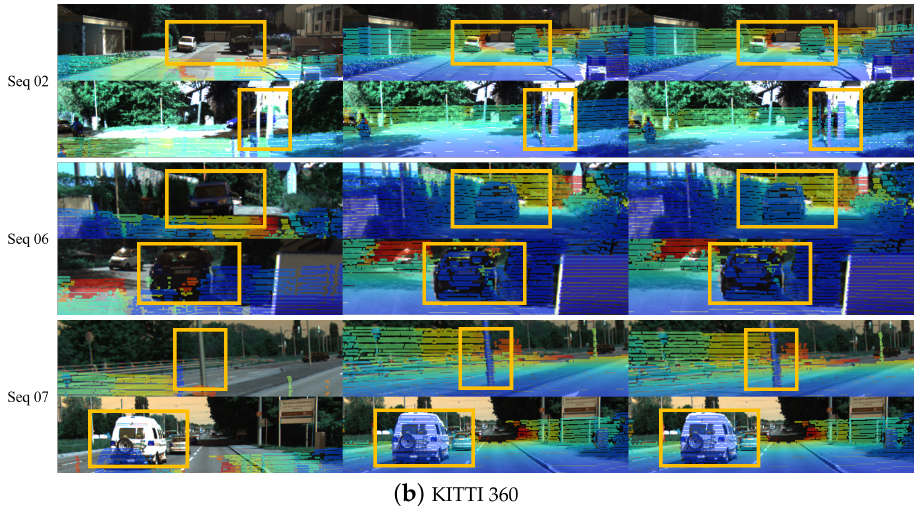
Figure 7. Examples of the calibration results with measurement initial extrinsic parameters using the KITTI odometry and KITTI 360 datasets. Each row represents a different test sequence. Images were cropped for better visualization, and the reference objects are shown in the rectangles.